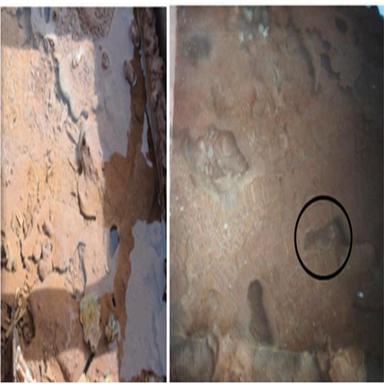
Formation of crust at the top plenum of the core catcher and water ingression zones.